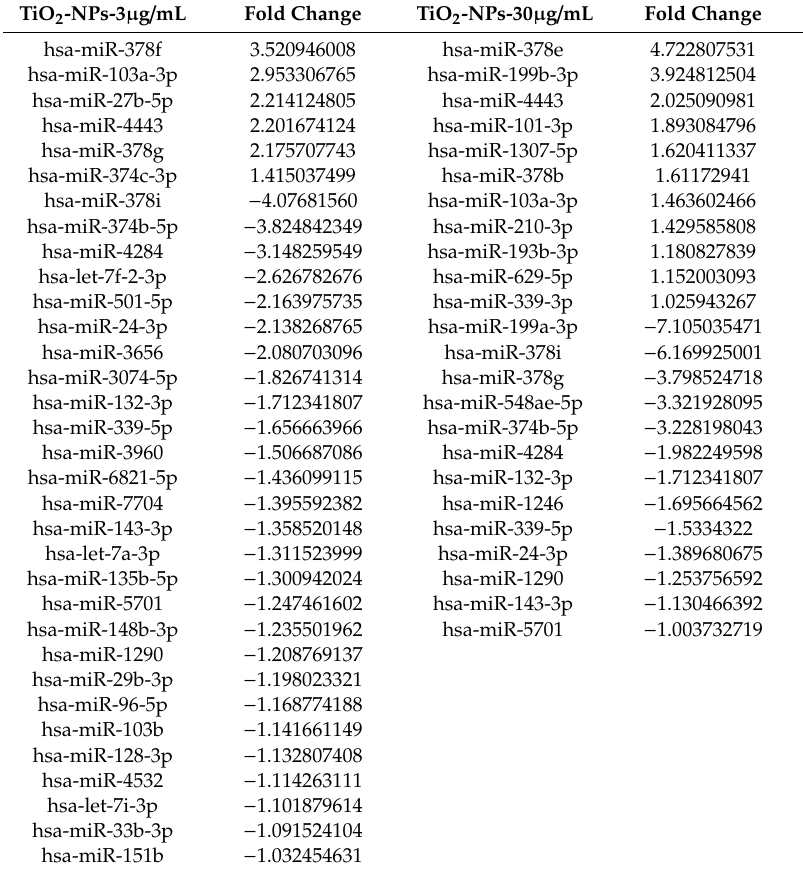
Figure 5. Graph of statistical numbers of differentially expressed microRNA. X-axis represents each pair of differential alignment schemes, and Y-axis represents the corresponding number of differential microRNAs. A vs B means sample B is the control and sample A is the case. If a gene is upregulated it means the expression of this gene is upregulated in sample A compared to sample B. Table 4. List of total microRNAs significantly regulated by TiO 2 -NPs. The fold change was the log2-Ratio value, cut-off at log2-Ratio ≥ 1 or log2Ratio ≤ − 1.